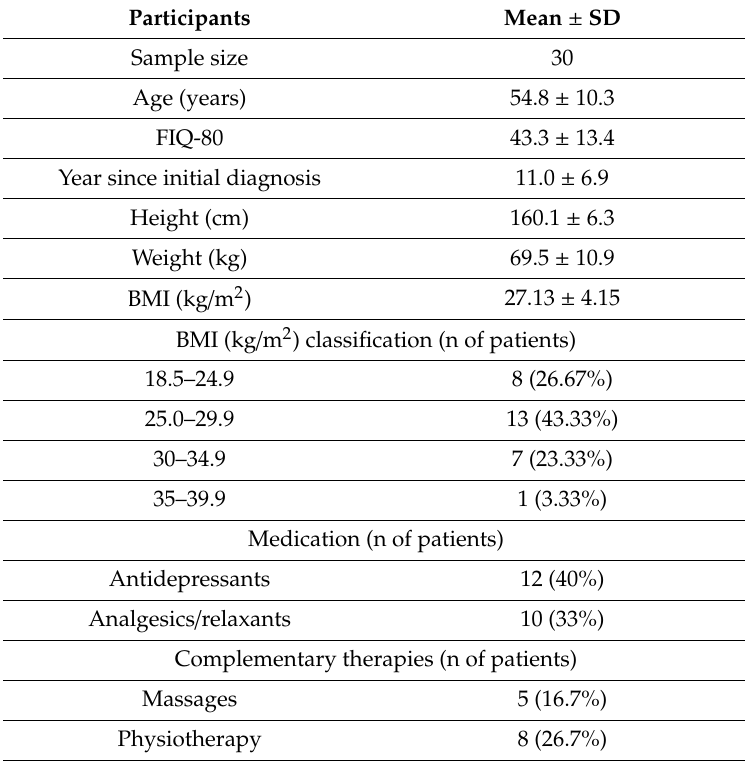
Table 1. Descriptive characteristics of the